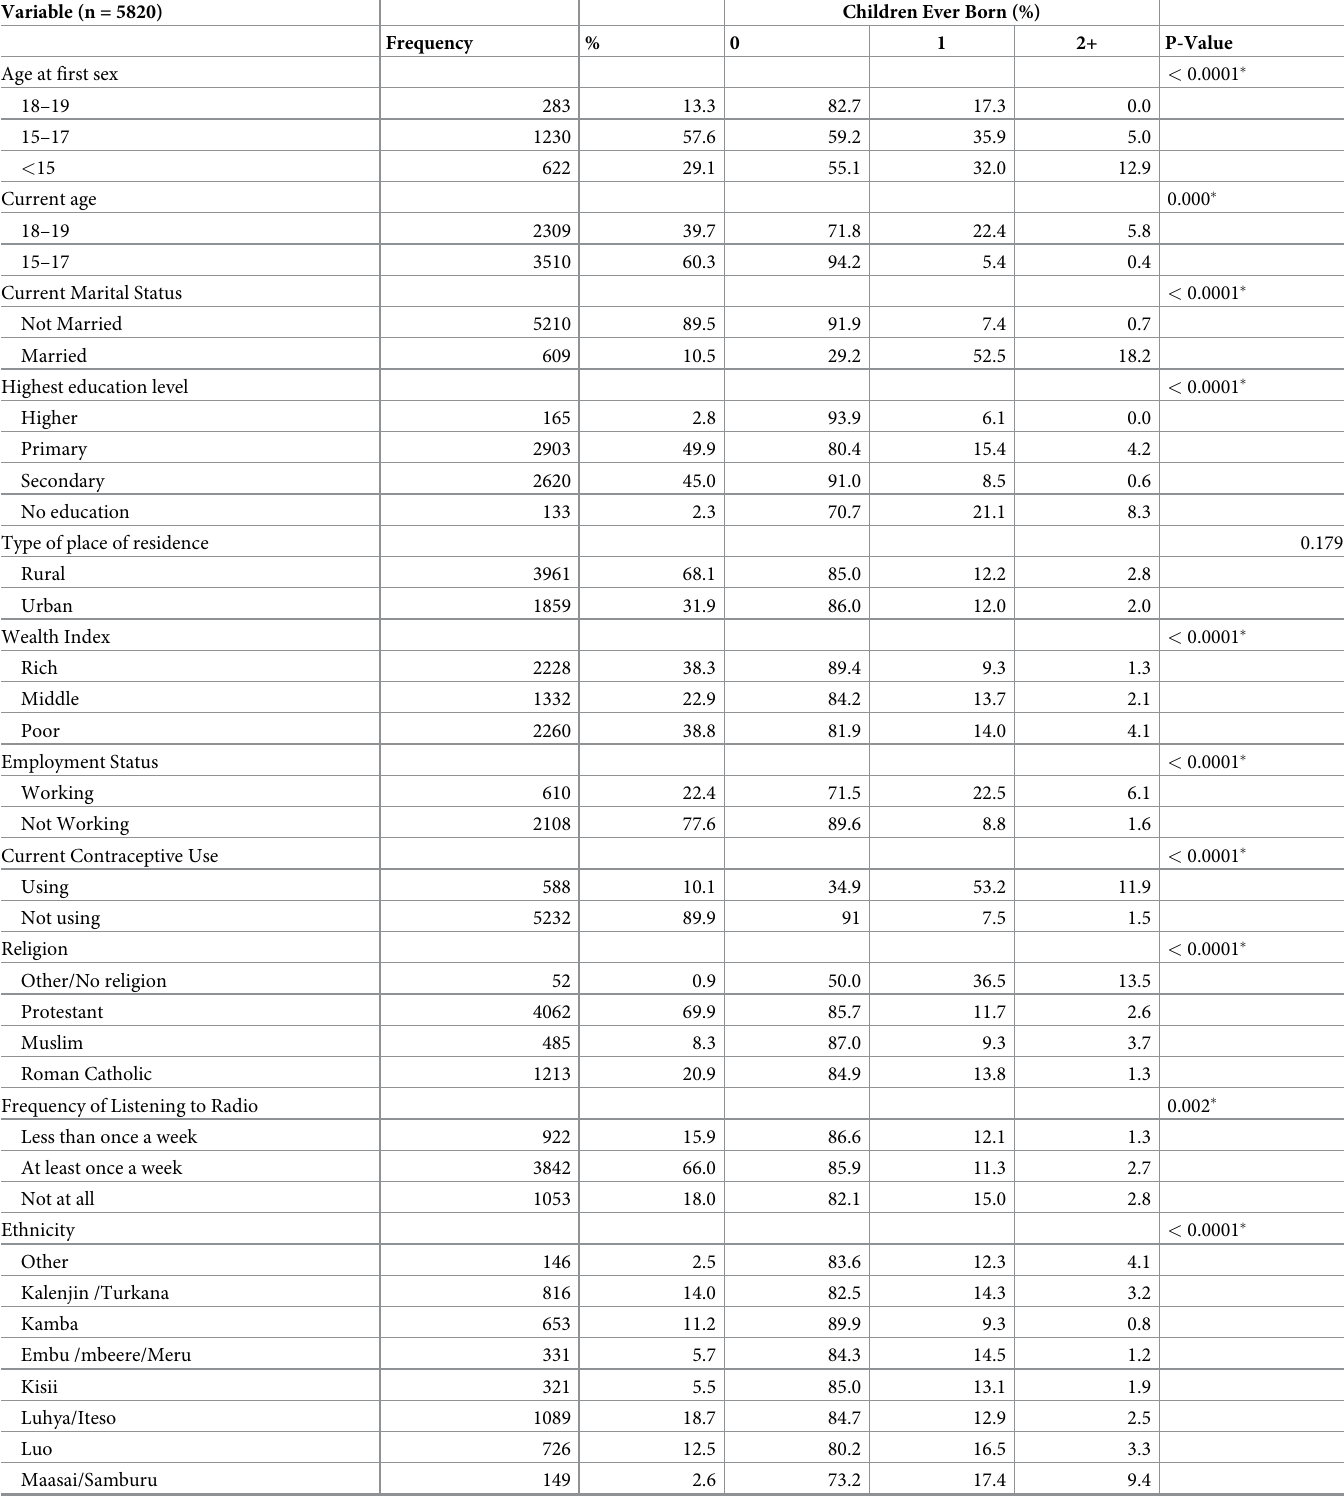
Table 1. Variables distribution and association of adolescents fertility in Kenya,